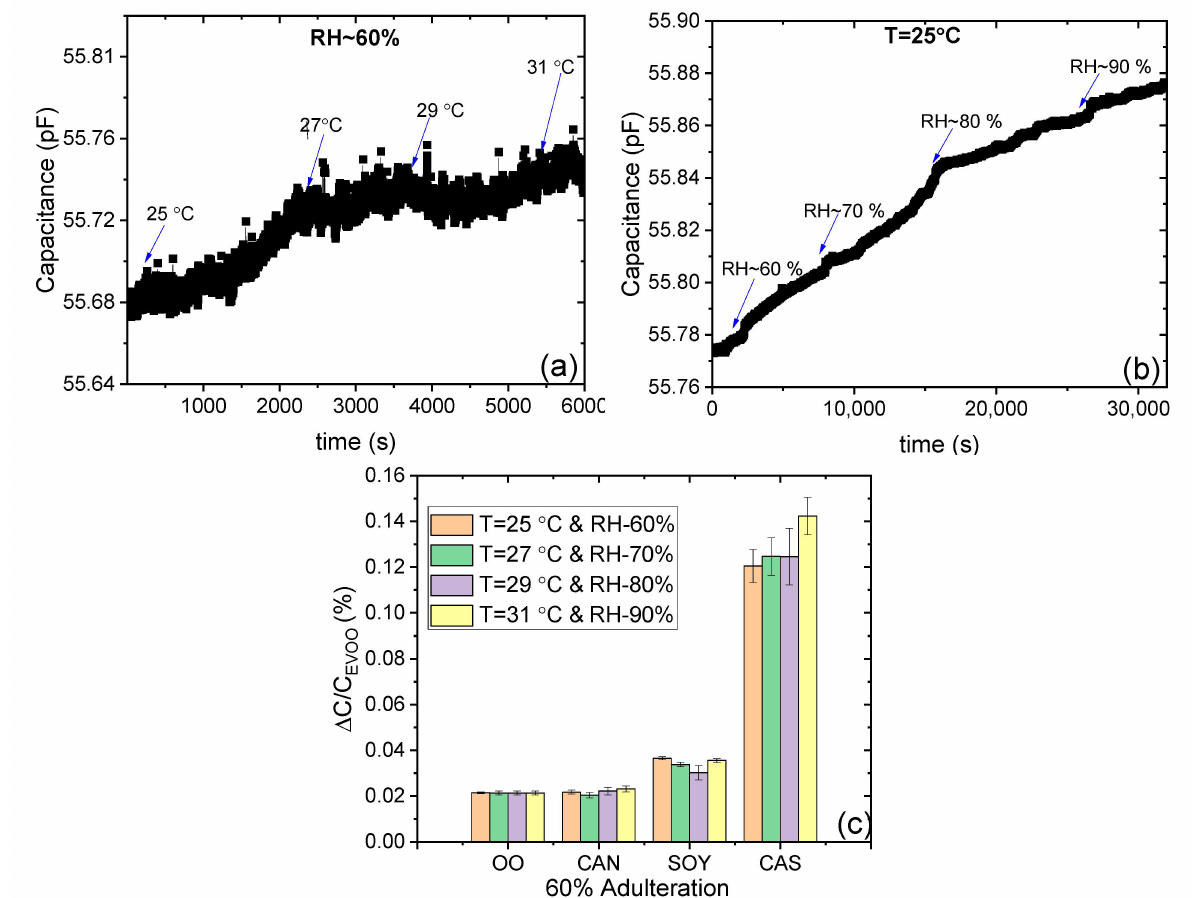
Figure 8. Effect of ambient conditions: ( a ) Real-time capacitance of the bare sensor with increasing ambient temperature and constant RH~60%. ( b ) Real-time capacitance of the bare sensor with increasing ambient RH and constant temperature (25 ◦ C). ( c ) Comparison of ∆ C EVOO /C EVOO ( ± σ ) for 60% adulteration at different temperatures and RH conditions. Olive oil − OO, soybean oil − SOY, canola oil − CAN and castor oil −